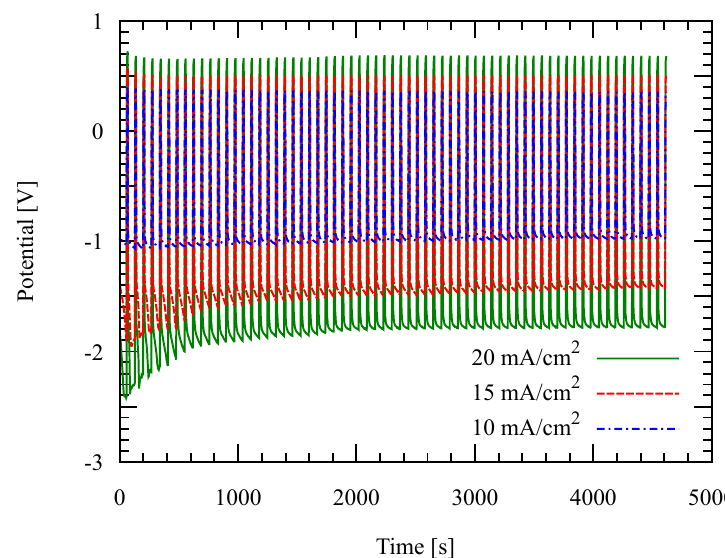
Figure 7. Deposition potential as a function of time during the deposition at 30 ◦ C with different current densities. Negative potential shows the deposition potential.